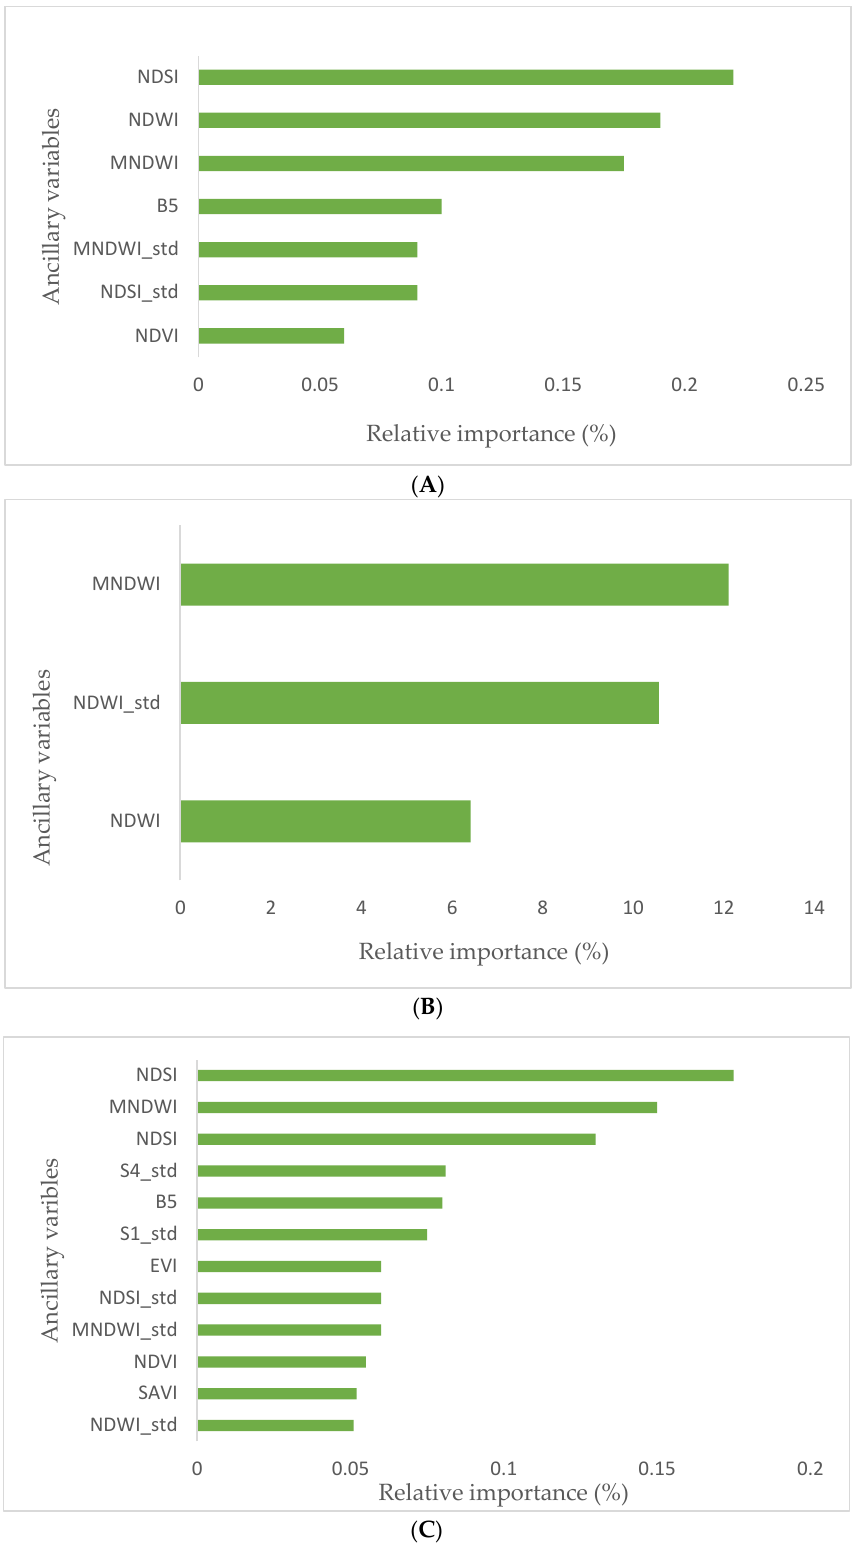
Figure 6. L8 ( A ) feature importance with RF; ( B ) feature importance with XGBoost; ( C ) feature importance with ETD.